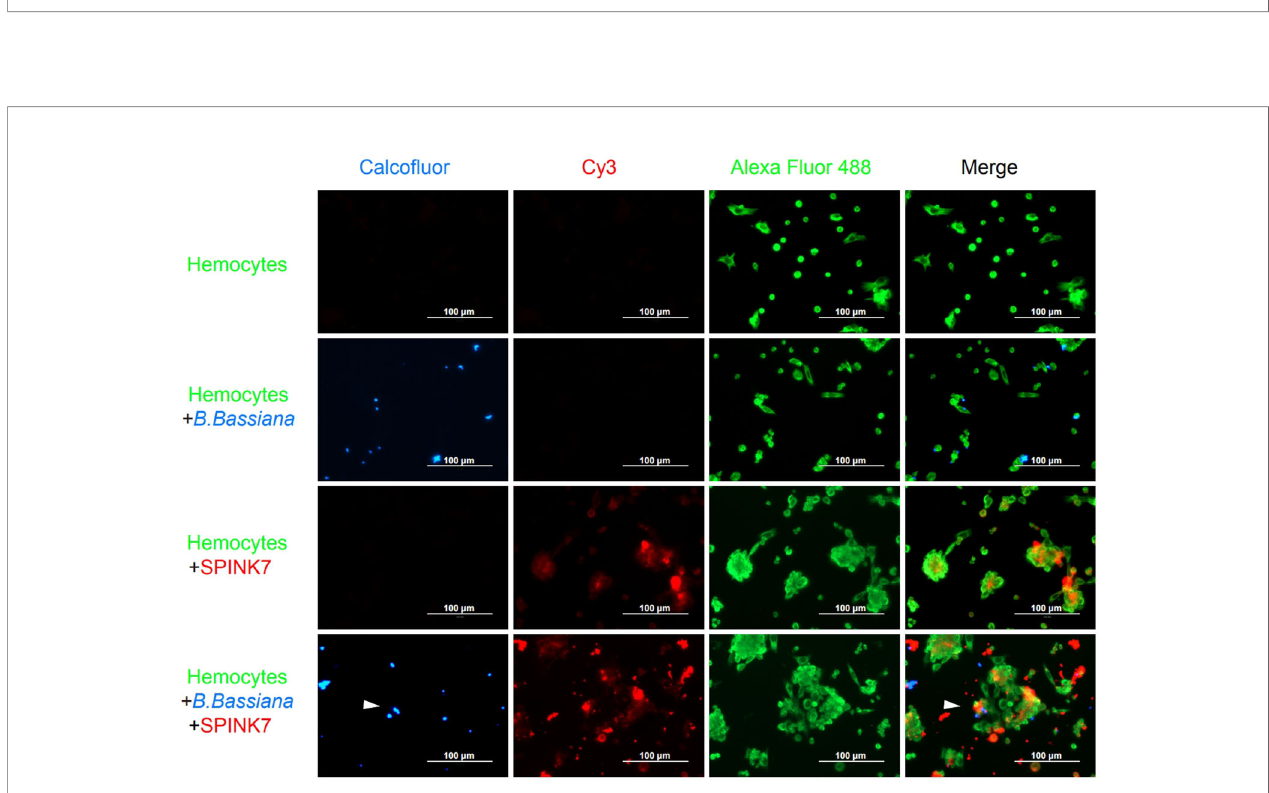
FIGURE 9 | Immuno fl uorescence visualization of SPINK7 in B. mori hemocyte immunity. Overlay experiments were performed on hemocyte monolayers prepared by seeding 5×10 3 hemocytes collected in phenylthiourea onto poly-L-lysine-treated glass slides. About 10 m L SPINK7 (5 m g m L -1 ) and 10 m L heat-killed B. bassiana spores (1×10 5 conidia mL -1 ), which were labeled by Calco fl uor White M2R (blue), were added to hemocyte monolayers and incubated at 25°C for 2 h. Slides were incubated with anti-SPINK7 and anti-tubulin antibodies, followed by Cy3-labeled goat anti-rabbit (red) and Alexa Fluor 488-labeled goat anti- mouse (green)